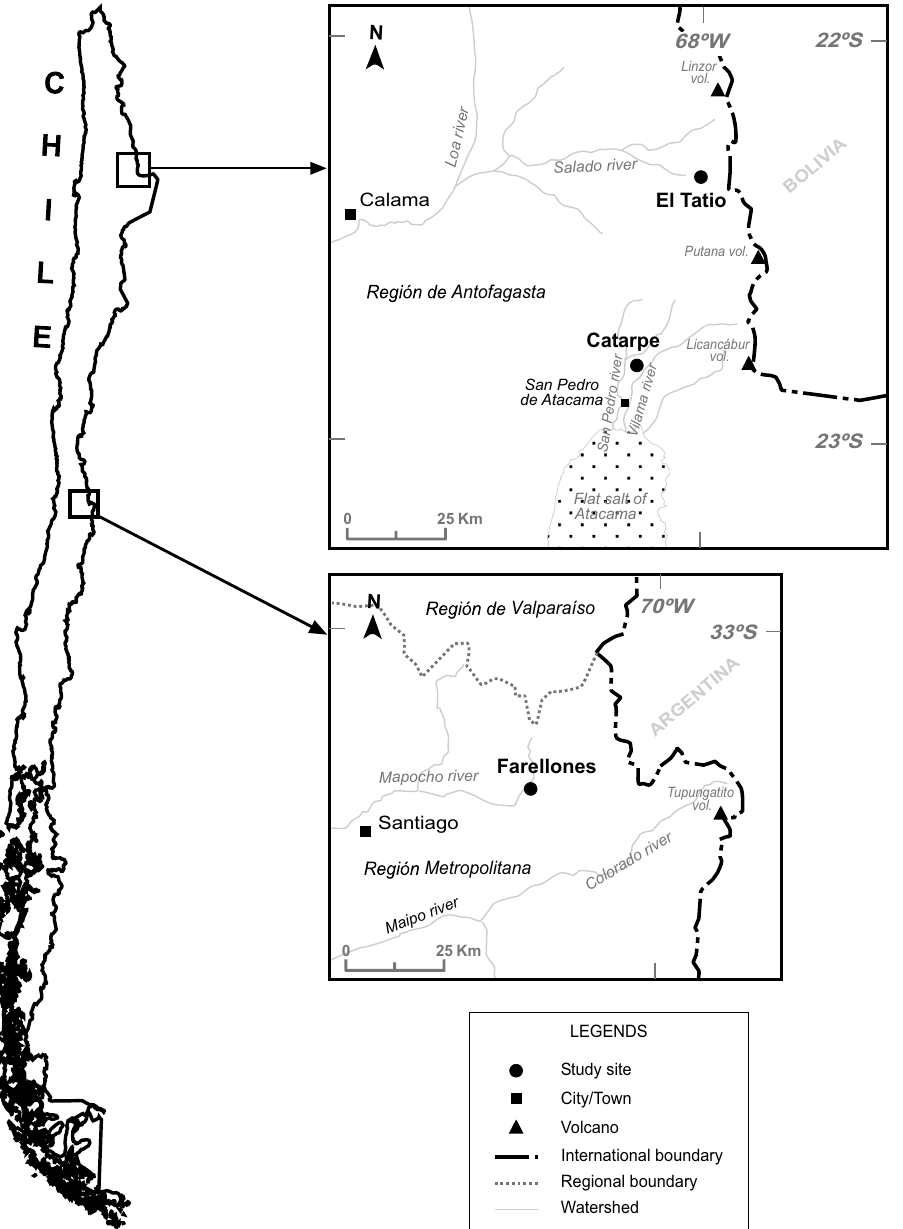
Figure 1. Sampling sites where egg collection of Rhinella spinulosa was carried out. Región de Antofagasta, Chile (top): El Tatio Geysers, geothermal permanent streams, and Catarpe valley, permanent streams with a daily thermal gradient. Región Metropolitana, Chile (bottom): mountain plains near Farellones, the control locality. The map was generated from digital information available at Google Earth Pro v7.1.4.1529 (https:// www.google.com/intl/es/earth/) modified with FreeHand MX v11.0.2